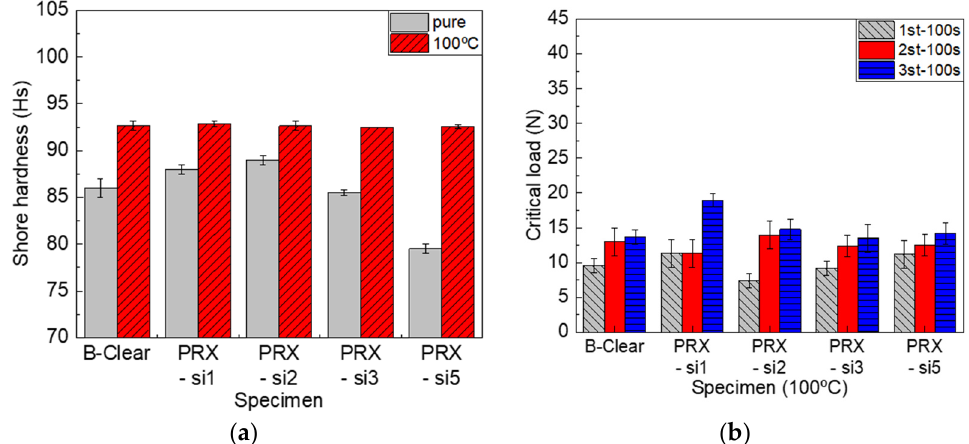
Figure 7. Effect of thermal degradation at 100 °C for 48 h on Shore hardness ( a ) and scratch critical loads ( b ) of B-clear and PRX-Si specimens.